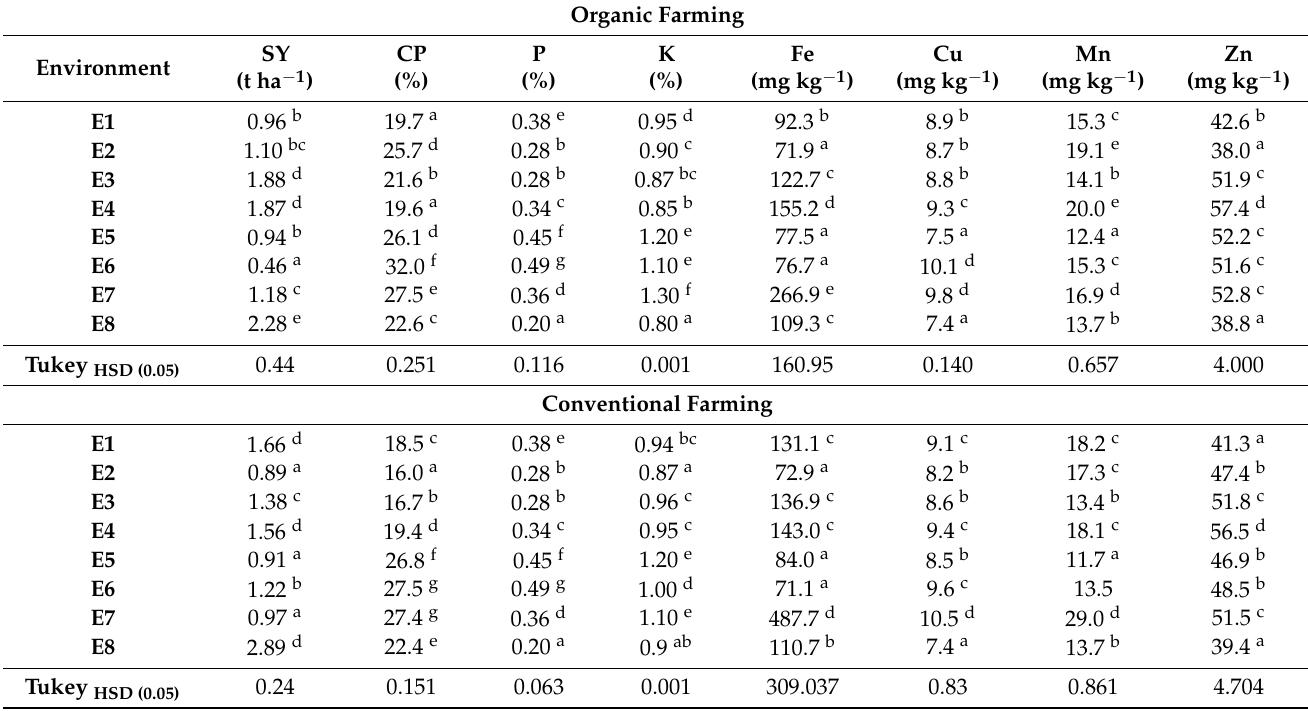
Table 3. Comparison of means for seed yield (SY), seed crude protein (% CP), seed macronutrient (% P, K) and micronutrient (Fe, Cu, Mn, Zn, mg kg − 1 ) contents originated from eight environments averaged across five lentil genotypes (G) at harvest in organic and conventional farming. Organic Farming